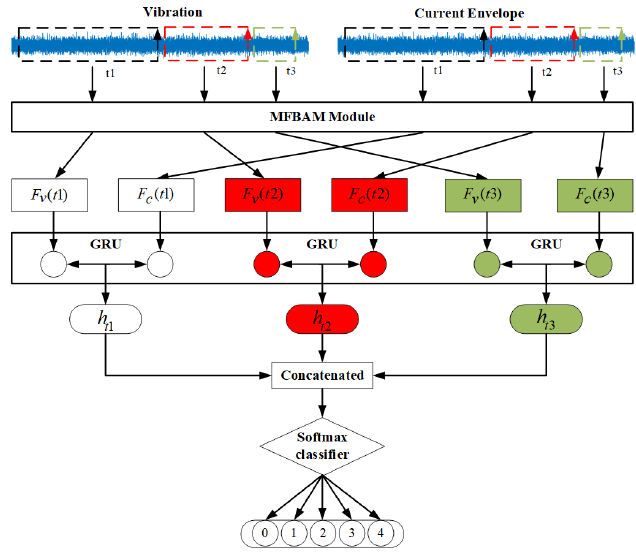
Figure 5. Overall framework of fault diagnosis